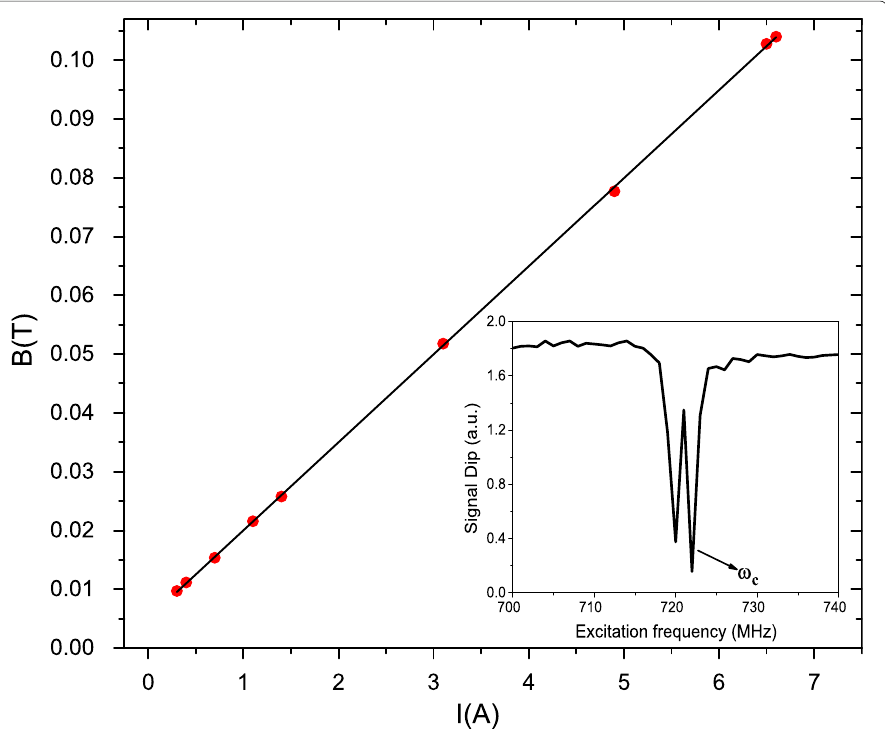
Fig. 4 Magnetic fields obtained from the motional spectrum shown as a function of the current in the electromagnet. Inset shows the dip corresponding to the cyclotron frequency from the motional resonance